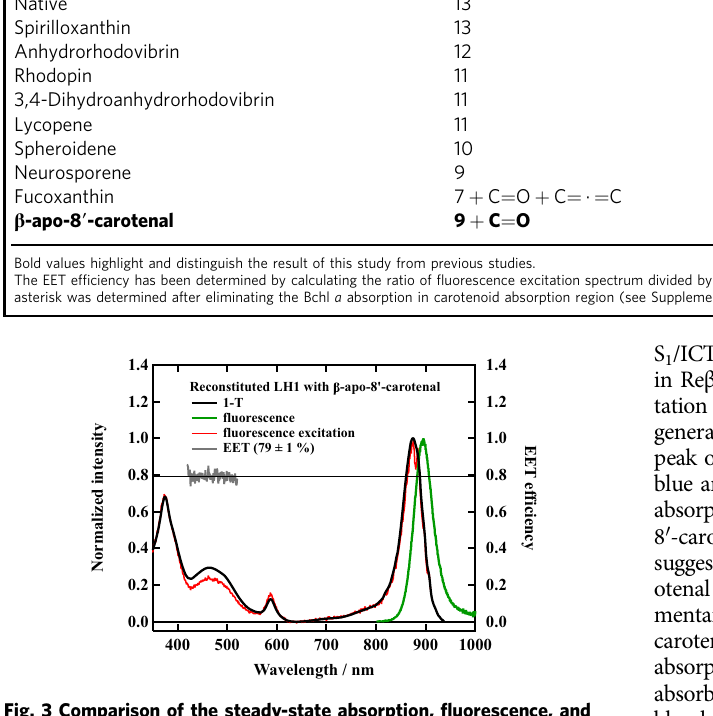
Fig. 3 Comparison of the steady-state absorption, fl uorescence, and fl uorescence excitation spectra of Re β apo. Steady-state absorption spectrum (solid black line) displayed as 1 – T (Transmission), fl uorescence spectrum excited at 500 nm (solid green line), fl uorescence excitation spectrum monitored at 920 nm (solid red line), and the ef fi ciency of EET from β -apo-8 ′ -carotenal to B880 Bchl a (solid gray line) are shown